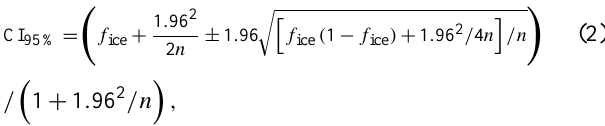
Table 2. Numbers and concentration of cultivable fungi and ice nu- cleating M. alpina in different soil